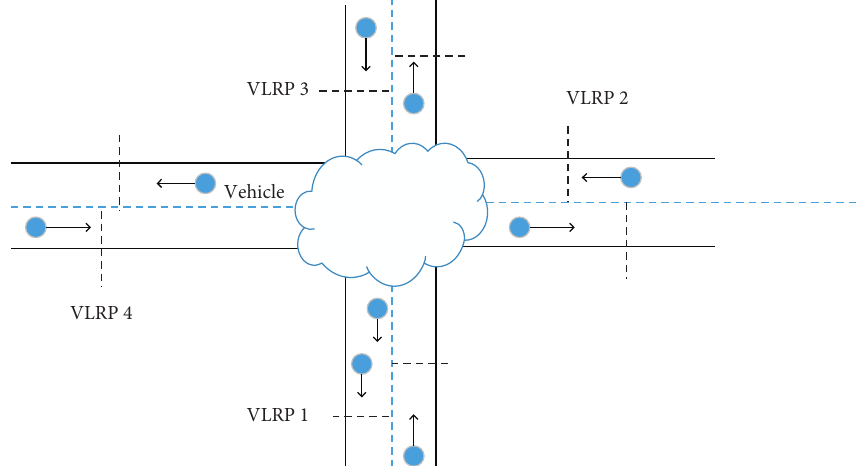
Figure 3: Intersection situation (Case 2).